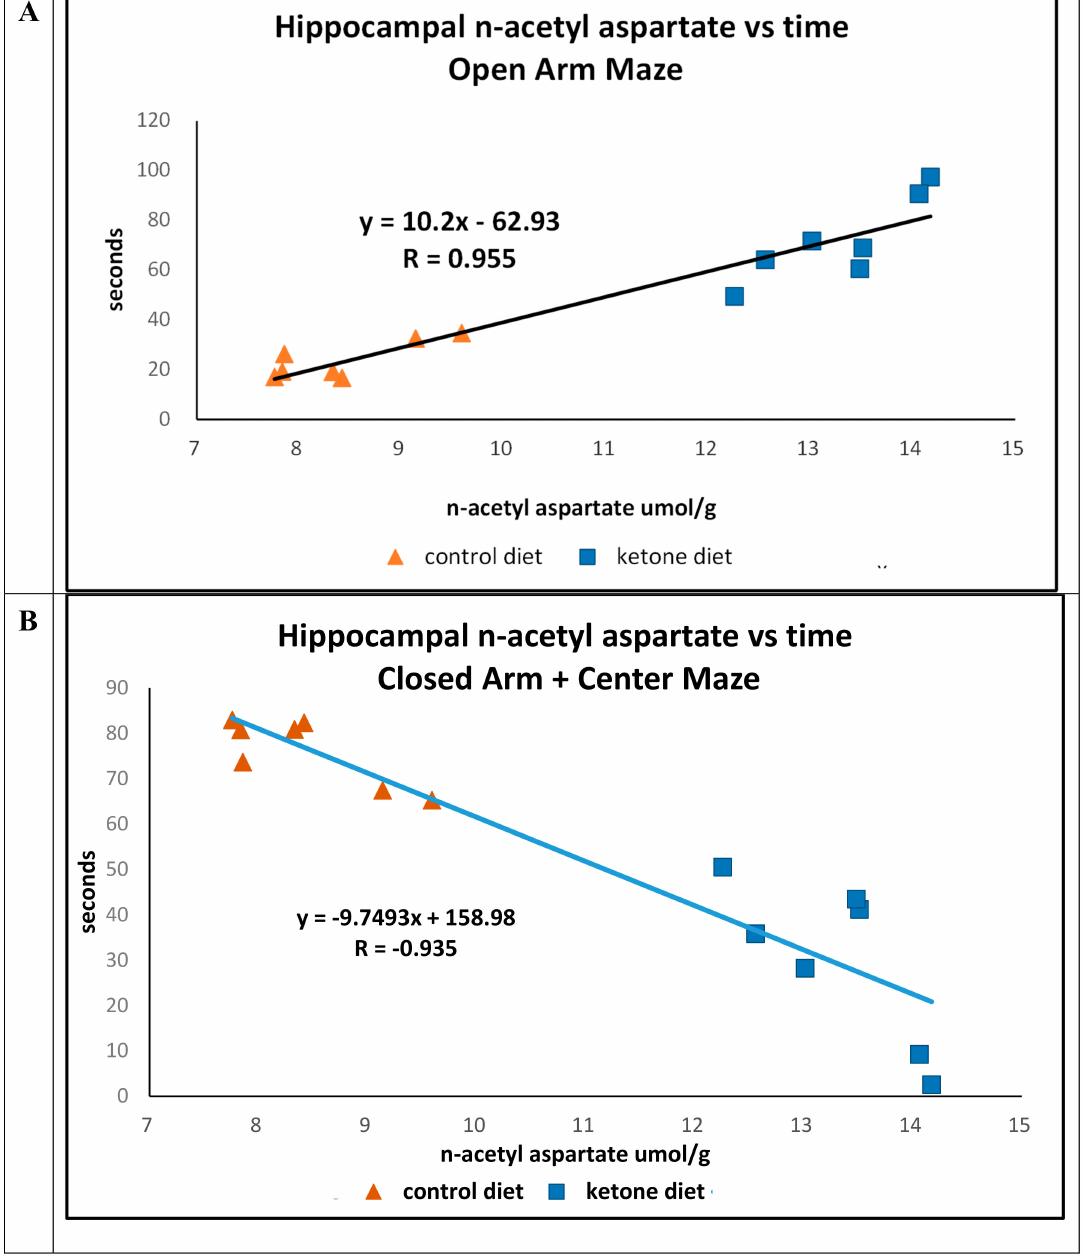
Figure 3. Elevated open- and closed-arm maze assessments of 3xTgAd mice fed either a control diet (n = 7, triangle) or ketone ester diet (n = 7, square) for 8 months, measured at 15 months of age. ( A ) Linear correlations comparing concentrations of hippocampal n-acetyl aspartate (assayed at 16.5 months) versus time spent in the open-arm portion of the maze, in seconds. ( B ) Hippocampal n-acetyl aspartate versus time spent in the closed-arm and center portions of the maze. In open field trials, there were strong positive associations between concentrations of hippocampal n-acetyl aspartate and total distance traveled (R = 0.952) (Figure 4A), ambulatory time (R = 0.874) (Figure 4B), and ambulatory counts (R = 0.853) (Figure 4C) in mice maintained on either the Cho or Ket